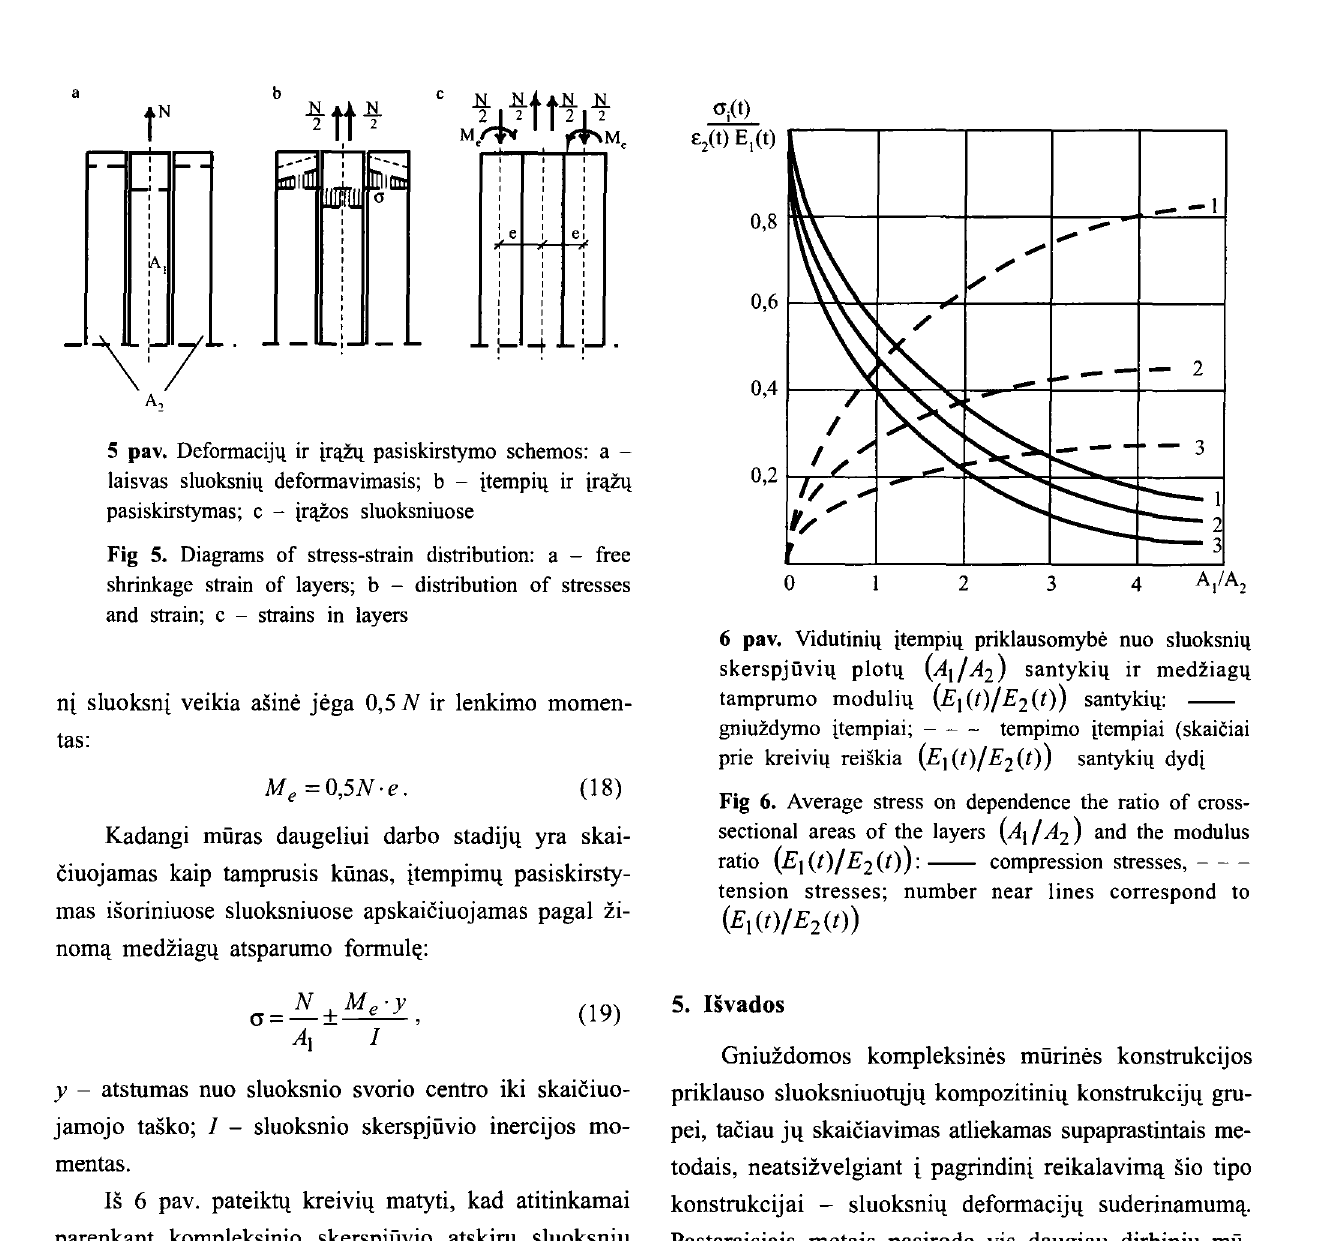
Fig 5. Diagrams of stress-strain distribution: a - free shrinkage strain of layers; b - distribution of stresses and strain; c - strains in layers